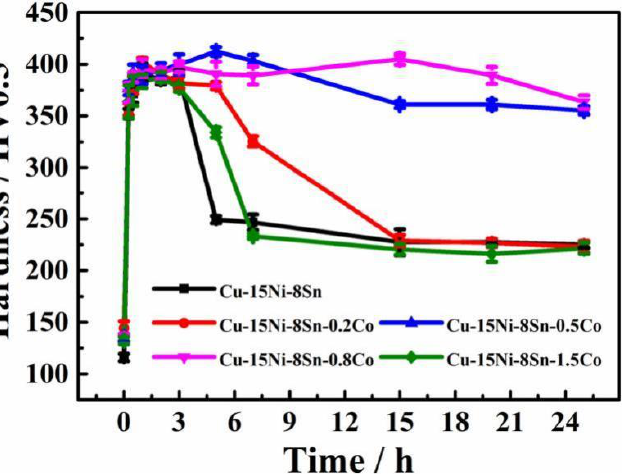
Figure 11. Aging hardening curves of alloys with different Co contents treated by 773 K isothermal aging [40] .